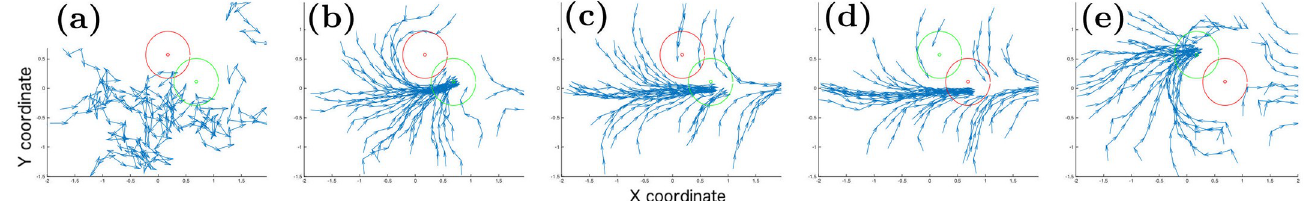
Fig 10. Analysis of the agent’s behaviour when freezing and unfreezing the neuromodulation signal and when changing task within an episode. The green reference is attributed a reward of 100 while the red one is attributed a reward of − 50. Each blue arrow represents the movement of the agent for a given time-step. (a) Shows the behaviour with z fixed at its initial value. In (b) we unlock z . Then, in (c) we lock z with its current value. Finally in (d) we switch the references before unlocking z once again in (e) .